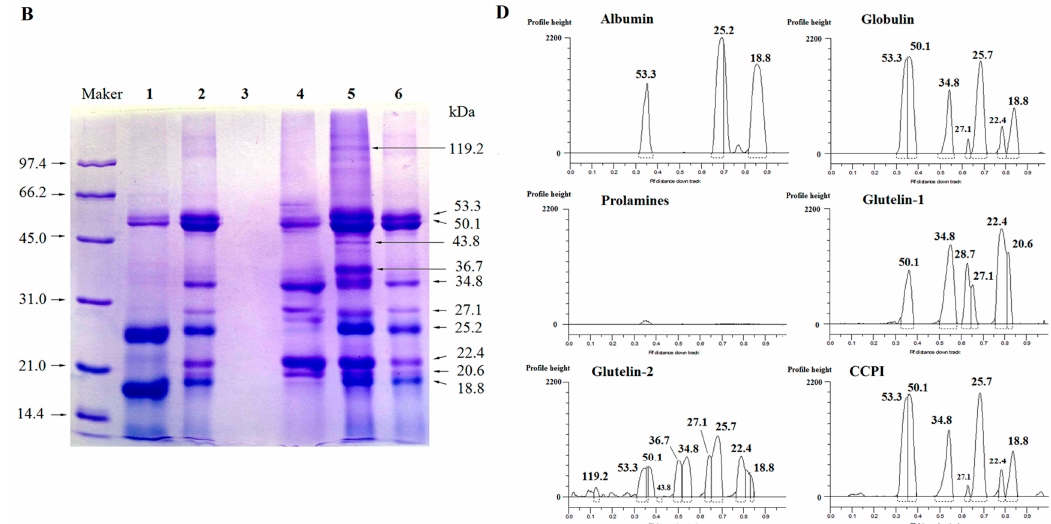
Figure 1. SDS-PAGE patterns and molecular weight distribution profiles of coconut cake protein fractions in the absence ( A , C ) or in the presence ( B , D ) of β -mercaptoethanol. Maker: molecular weight standards; Track 1: albumin, 2: globulin, 3: prolamine, 4: glutelin-1 and 5: glutelins-2; 6: coconut cake protein isolates (CCPI).